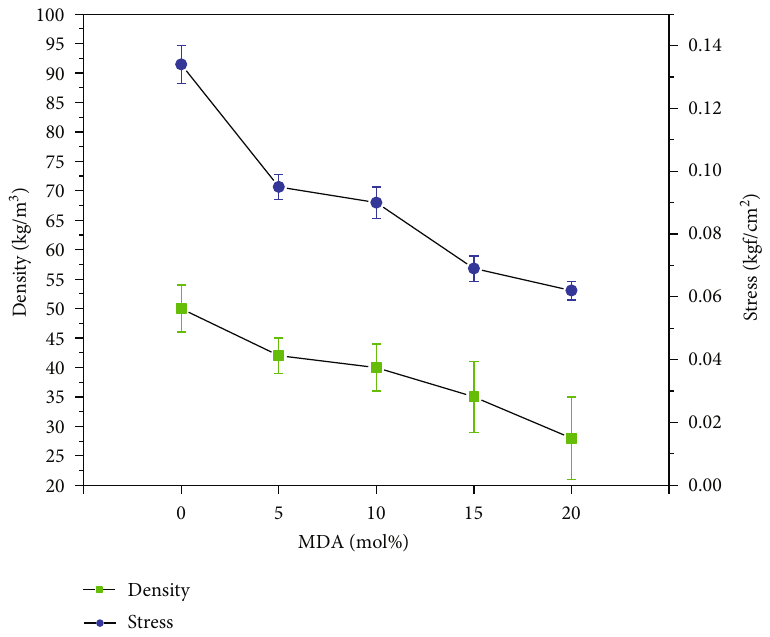
Figure 9: Density and 10% compression stress of PIFs with various HMDA